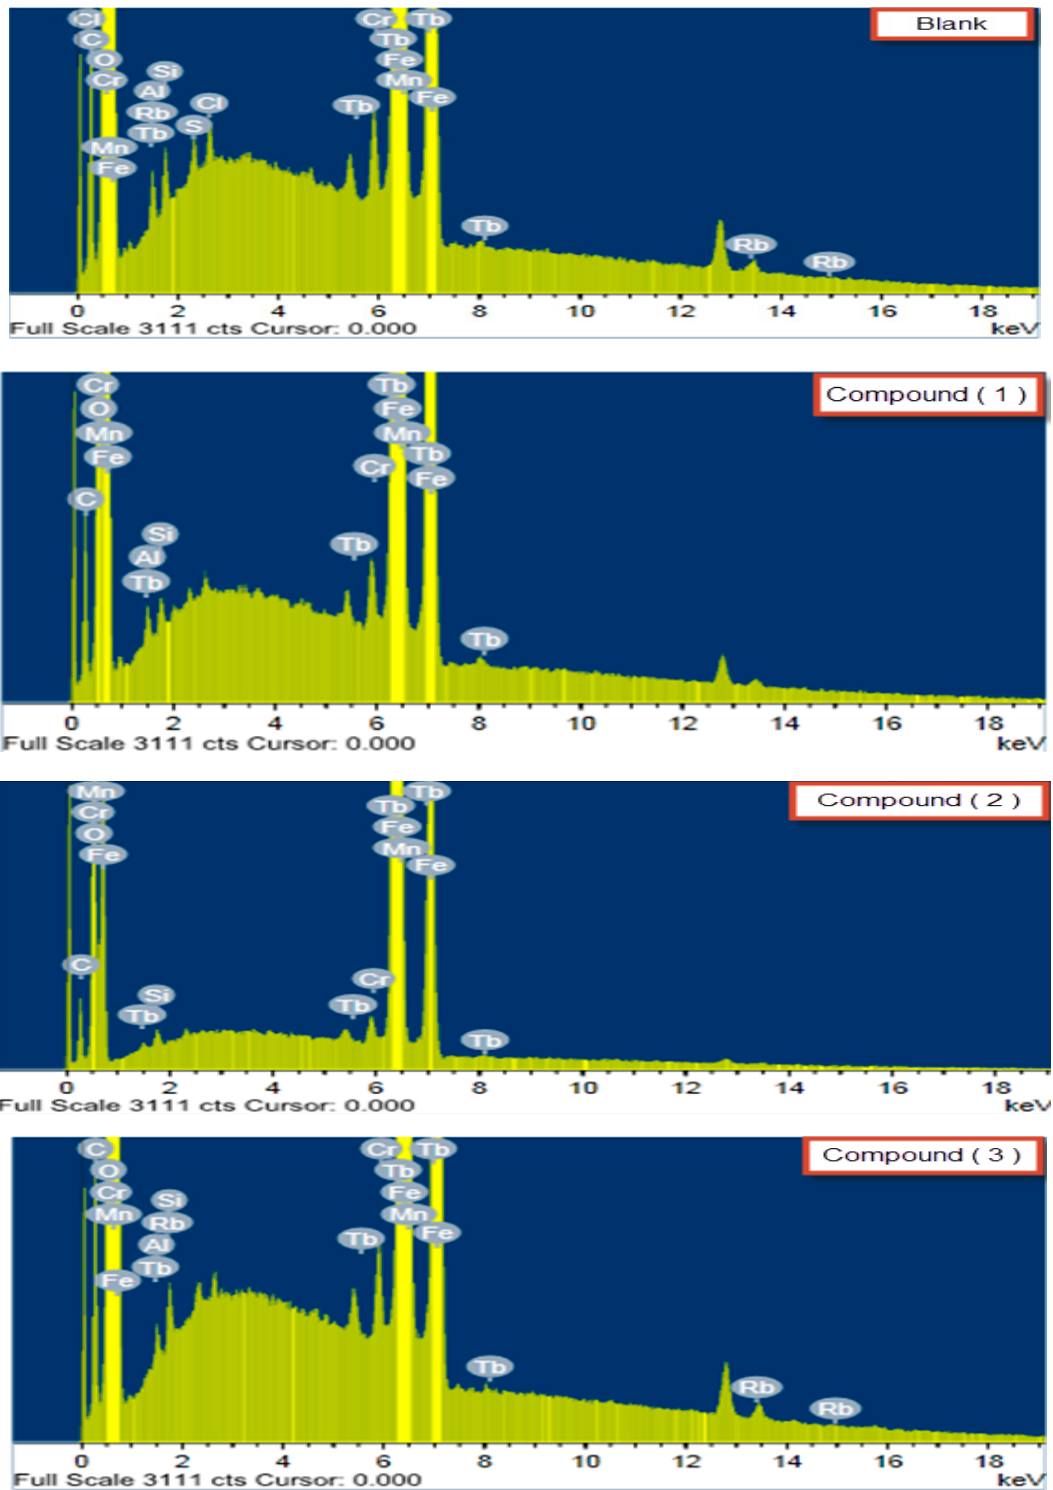
Figure 9. EDS study of Q235 steel after 3 days in corrosive environments attendance and lack of unlike dose of 11 × 10 − 6 M spiropyrazoles.